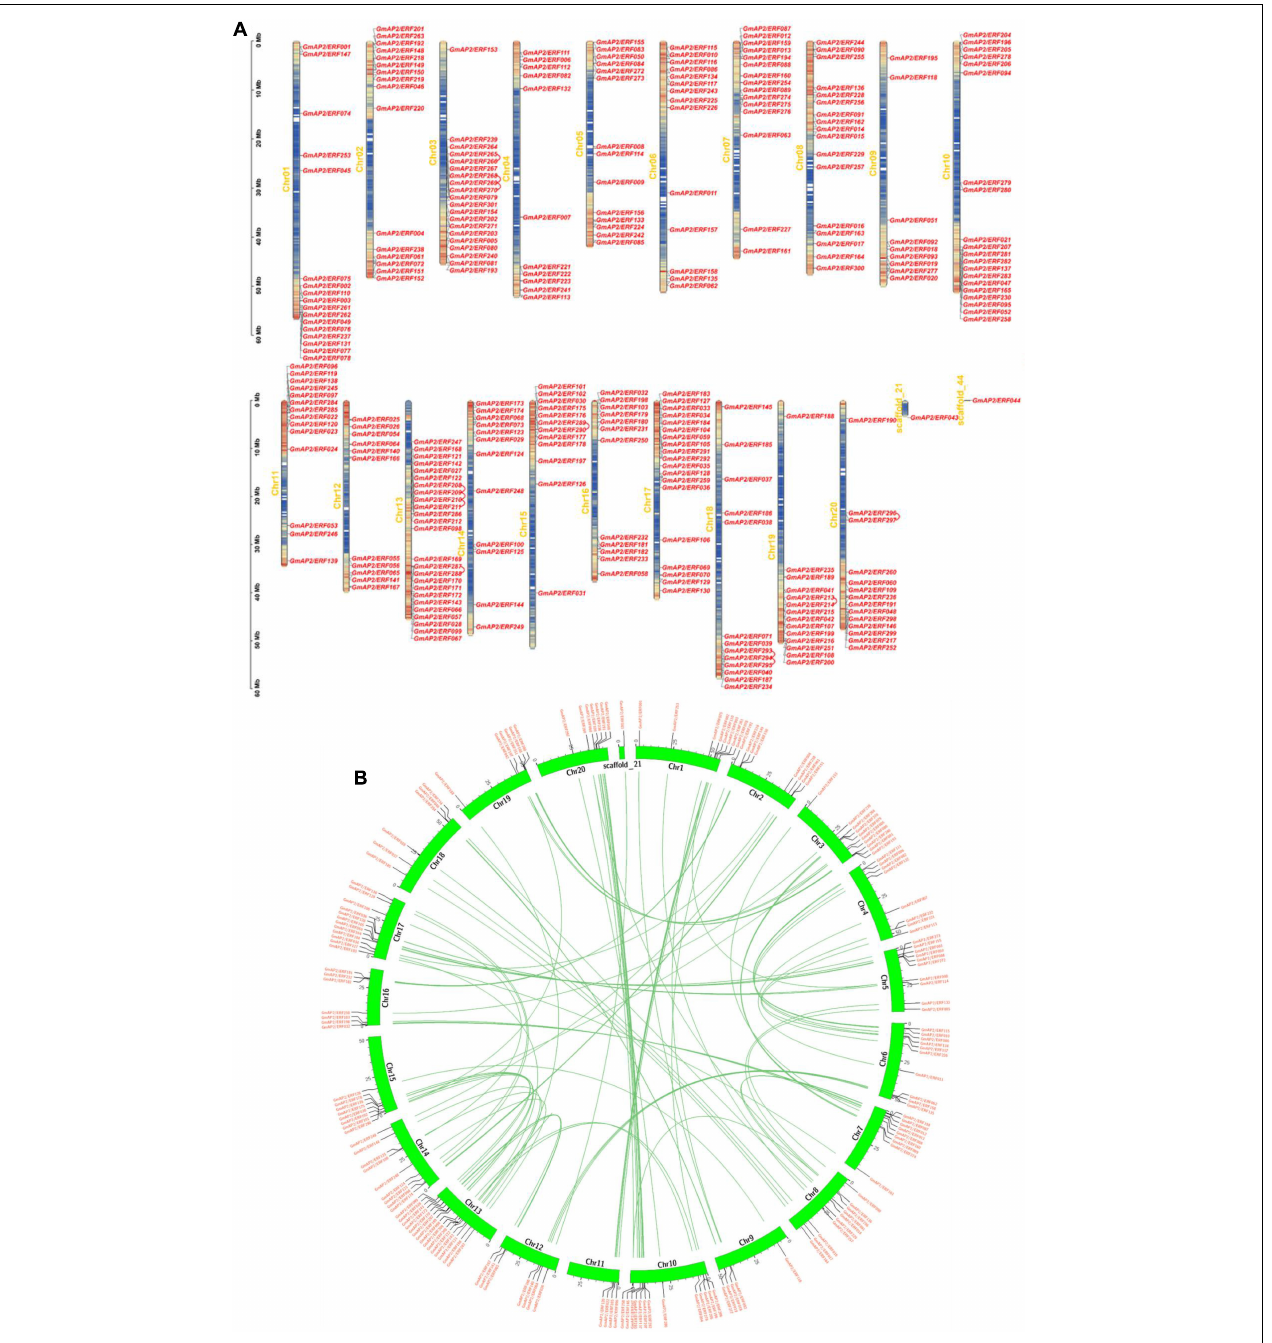
FIGURE 2 | Chromosomal distributions of GmAP2/ERF genes and schematic of interchromosomal relations. (A) Chromosomal distributions of GmAP2/ERF genes. Chromosomal (Chr) names in yellow are on the left, and gene names are on the right. Left-side scale is in megabases (Mb). Gradient colors from red (high) to blue (low) indicate gene density in heat maps on soybean chromosomes, by setting the estimated hereditary interval as 300 kb. Red indicates high gene density, and blue indicates low gene density. (B) Schematic of interchromosomal relations of soybean GmAP2/ERF genes. Green lines indicate all syntenic blocks in the soybean genome. Heat maps represent the gene